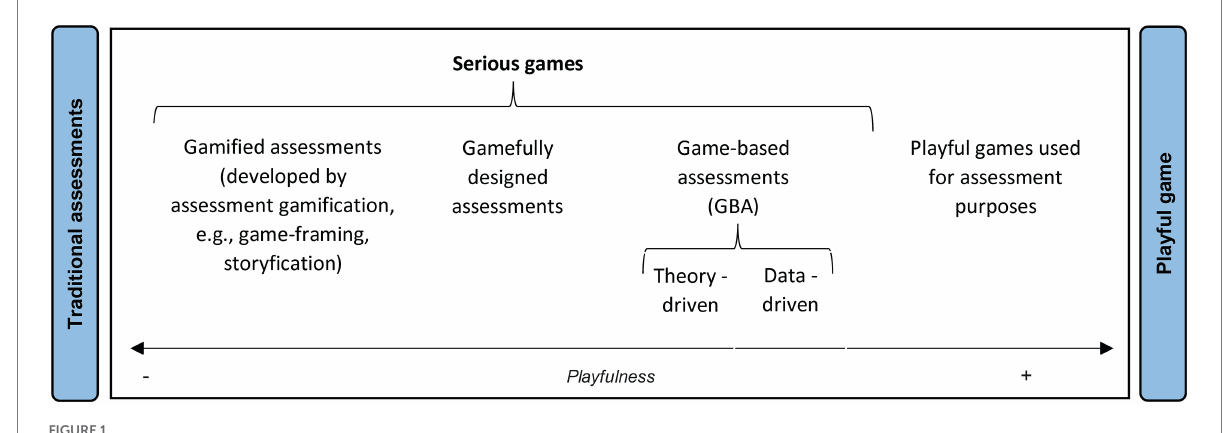
FIGURE 1 A classification of game-related